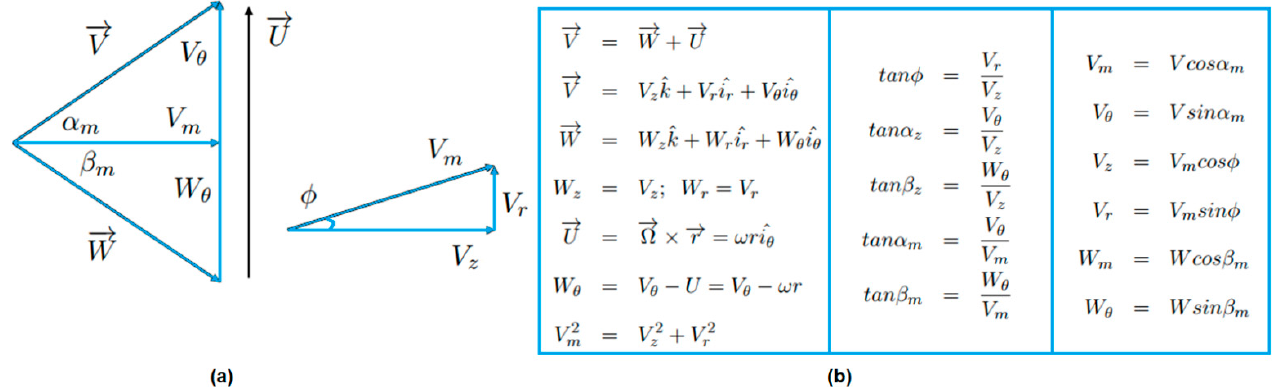
Figure 2. General velocity triangle is shown in (a) with streamline slope for high curvature and angle relationships with velocities are shown in (b).